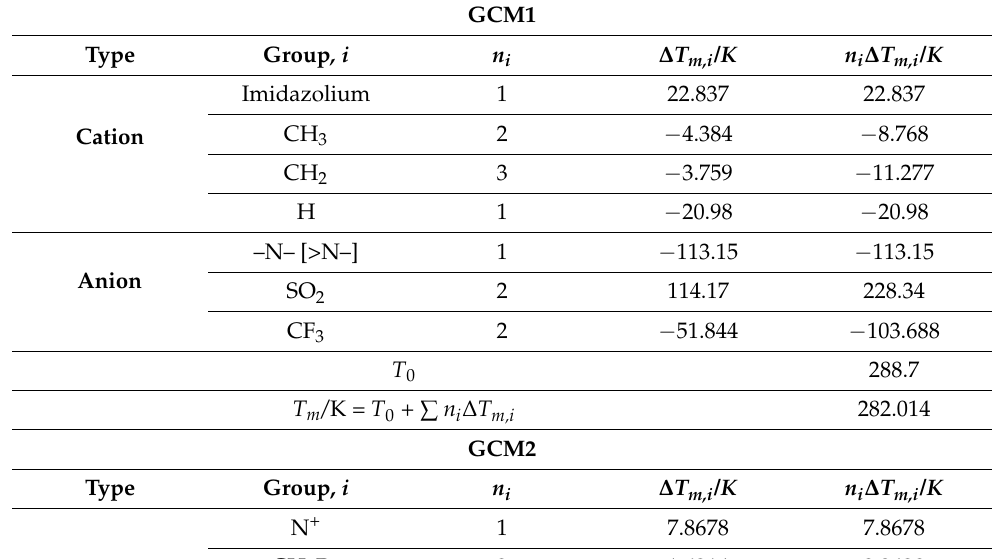
Estimation of the melting point of ILs using GCM1 and GCM2 with 1-butyl-3- methylimidazolium bis((trifluoromethyl)sulfonyl)imide as an illustration of the general